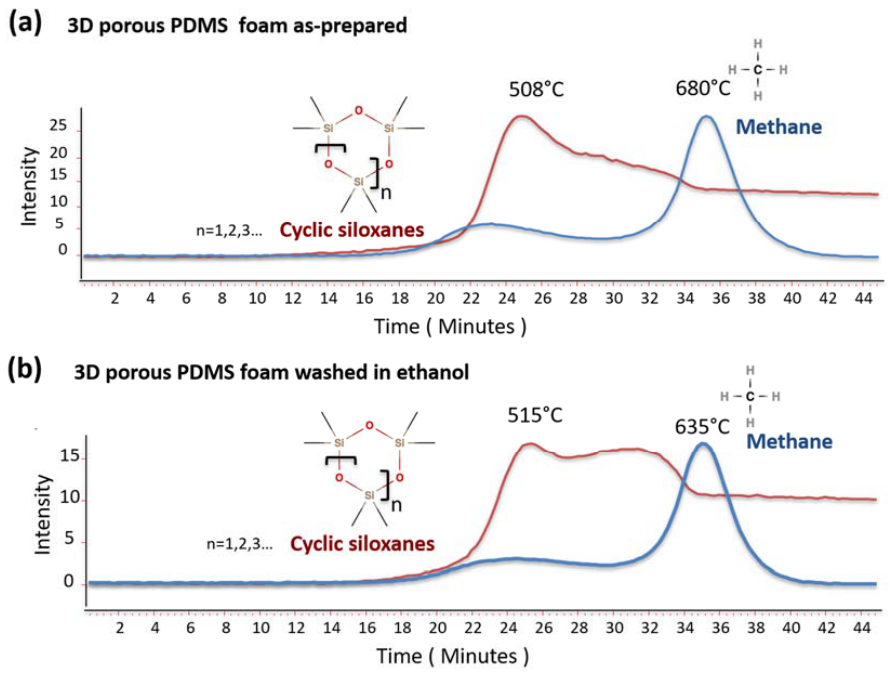
Figure 5. Evolution profiles of CH 4 and cyclic siloxane compounds from the TG/FTIR of 3D porous PDMS foam thermal decomposition at 20 °C min under N 2 .